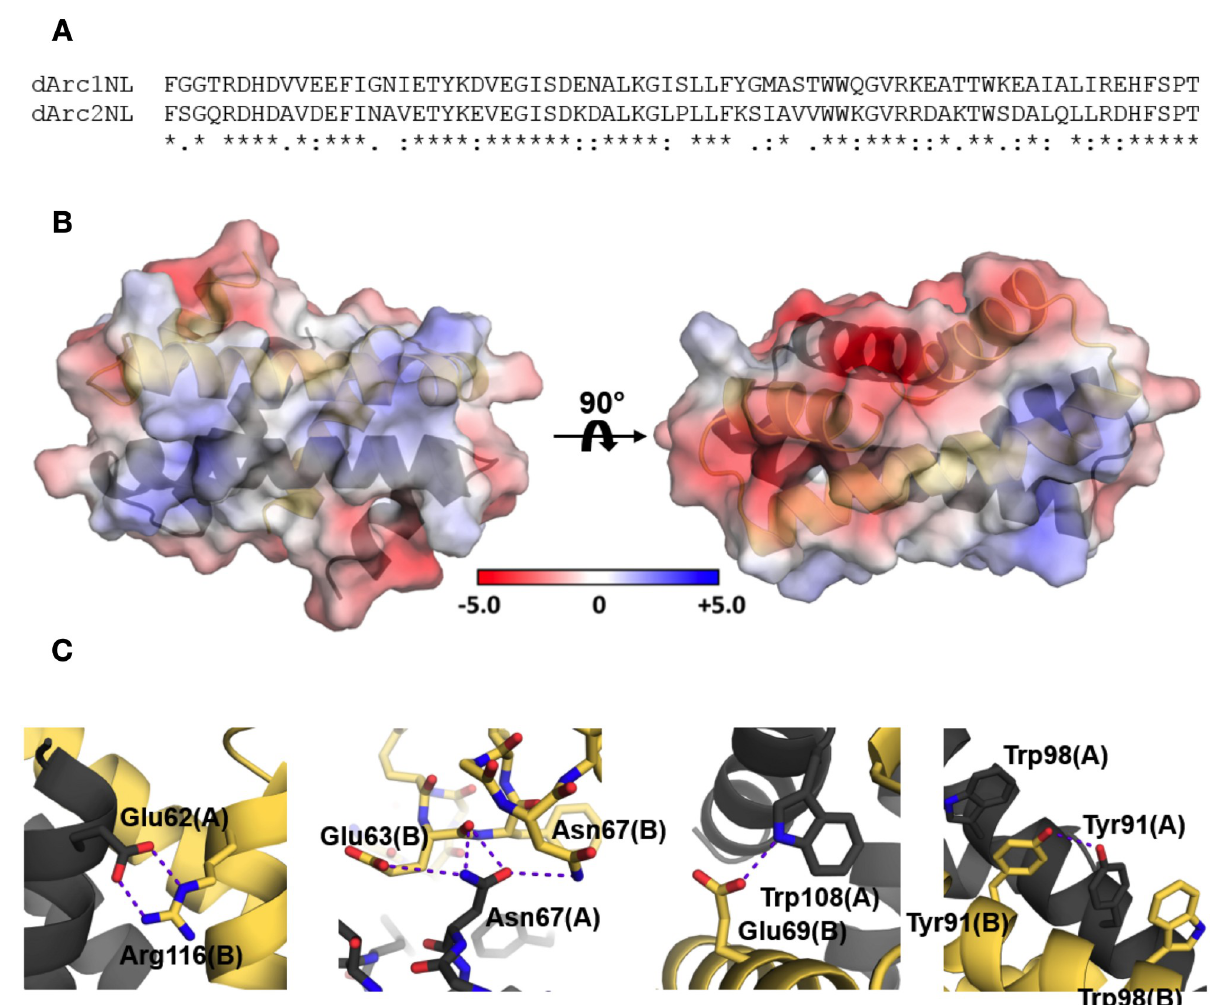
Fig 10. dArc1-NL homology model. (A) Sequence alignment between dArc1-NL and dArc2-NL. (B) The homology model of dArc1-NL displays contrasting electrostatic surface potential, where the highly positive character of dArc2-NL along α 2 and α 2’ (Fig 2) is replaced with a more modest surface potential. (C) Additional monomer-monomer interactions observed in the dArc1-NL model, not observed in the dArc2-NL crystal structure. Polar interactions are shown with purple dashed lines.